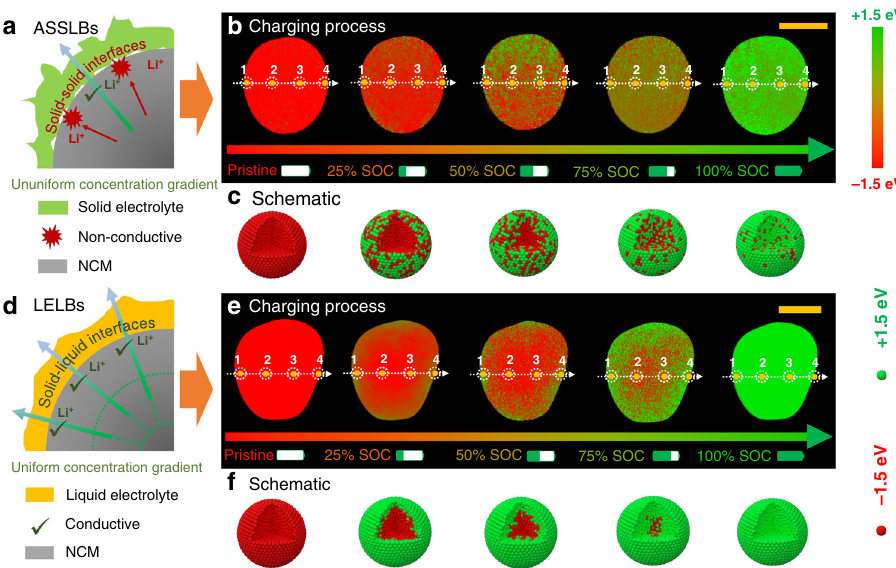
Fig. 2 In operando 2D TXM-XANES mapping during the initial charging process. ( a ) Schematic of solid-solid interface models and kinetics. ( b ) TXM- XANES mapping of single cathode particle as a function of charging time in ASSLBs, and ( c ) the corresponding schematic diagram to expound the unique solid-state electrochemistry. ( d ) Schematic of solid-liquid interface models and kinetics. ( e ) TXM-XANES mapping of single cathode particle as a function of charging time in LELBs, and ( f ) the corresponding schematic diagram expound the conventional solid-liquid electrochemistry. Scale bar, 10 μ